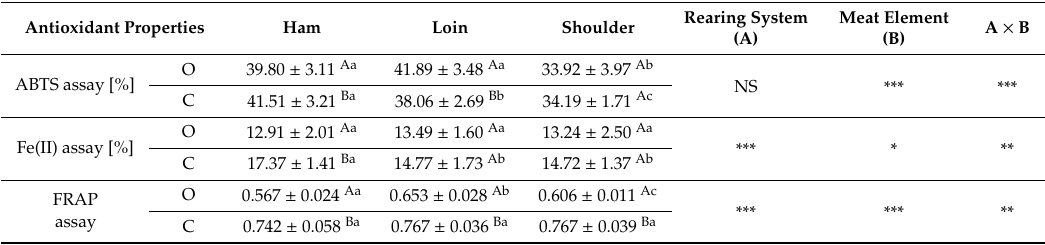
Table 4. The antioxidant properties of peptides based on in vitro analysis. ABTS: 2,2 (cid:48) -azino-bis-3 -ethylbenzthiazoline-6-sulfonic acid; FRAP: Fe(III) reduction power. Antioxidant